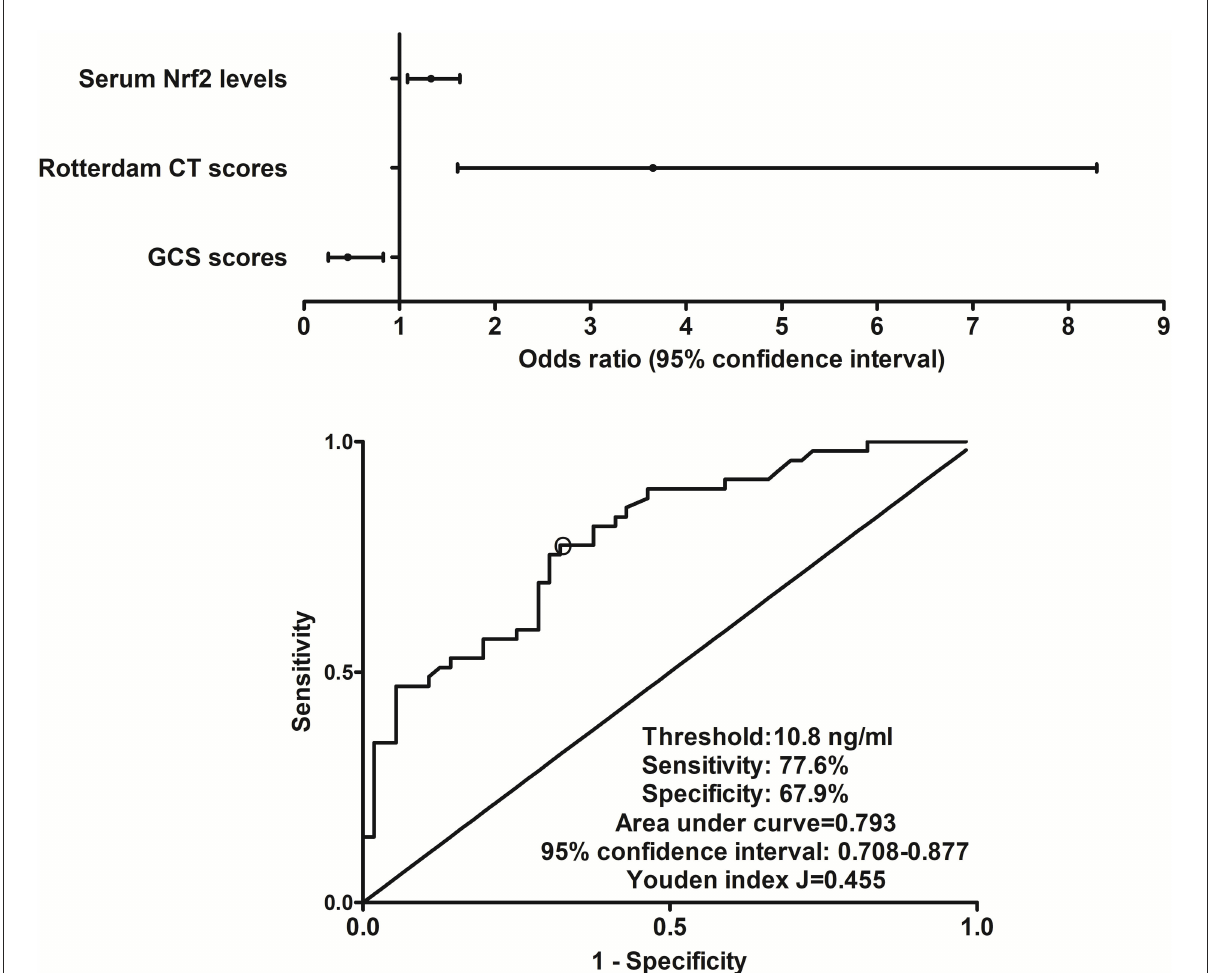
FIGURE7 Relationship between serum nuclear factor erythroid 2-related factor 2 levels and 180-day poor outcome after severe traumatic brain injury. Serum nuclear factor erythroid 2-related factor 2 levels, Rotterdam computed tomography scores, and Glasgow Coma Scale scores remained as the three independent predictors of 180-day poor outcome (extended Glasgow Outcome Scale scores of 1–4) following severe traumatic brain injury (all P < 0.05). Serum nuclear factor erythroid 2-related factor 2 levels markedly discriminated patients at risk of 180-day poor outcome based on receiver operating characteristic curve ( P < 0.001), and using Youden’s method, an optimal criterion of nuclear factor erythroid 2-related factor 2 levels was selected, which yielded medium–high sensitivity and specificity values for poor outcome prediction. Nrf2 indicates nuclear factor erythroid 2-related factor 2; CT, computed tomography; GCS, Glasgow Coma